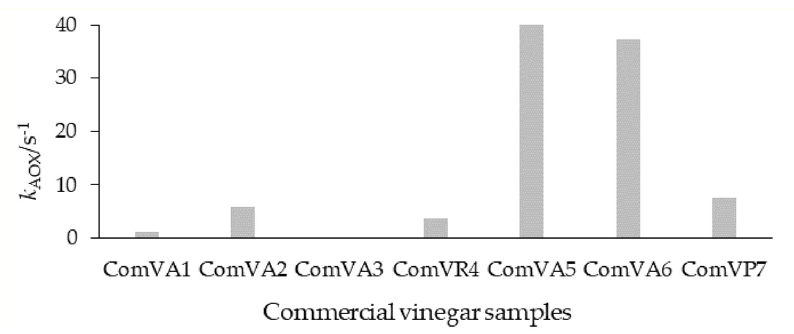
Figure 8. Antioxidant capacity constant (s − 1 ) of commercial fruit vinegars (ComV) over time (day), obtained by cyclic voltammetry: Agrar (ComVA1)—apple vinegar; Vitalia (ComVA2)—apple vine-